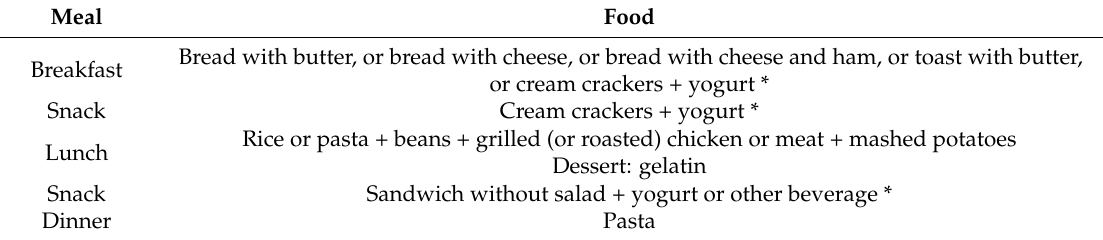
Table 1. Recommended diet, excluding: Whole food products (bread, cereals, flour, biscuits, etc.) nuts and seeds, almonds, fruit and fruit-containing products, vegetables, chocolate, alcoholic beverages, tea, and